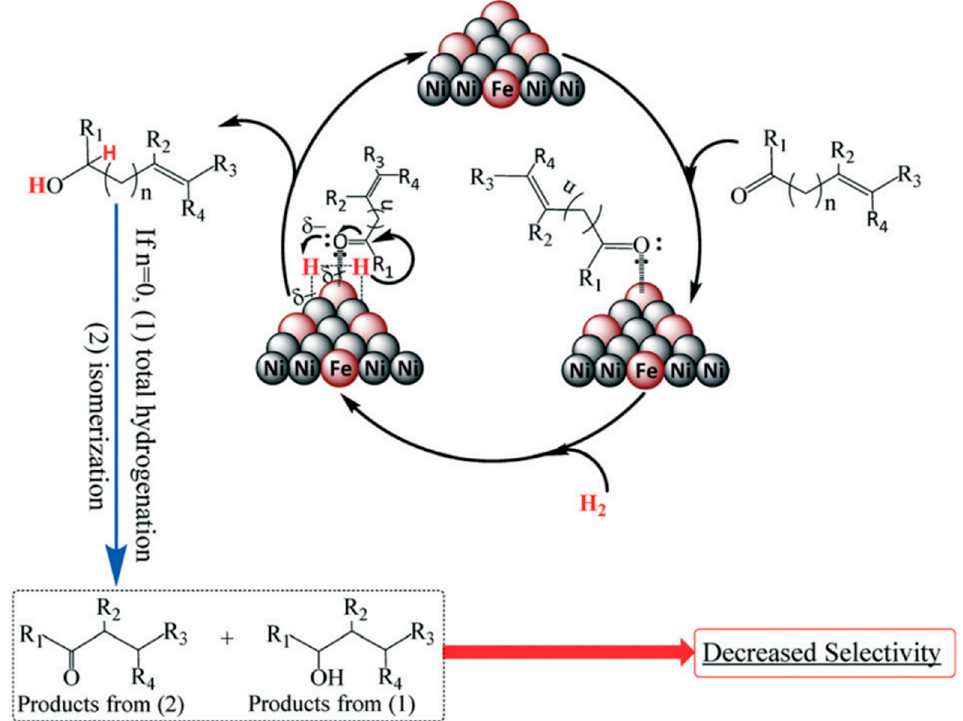
Scheme 2. Plausible mechanism for the chemoselective hydrogenation of unsaturated carbonyl compounds to the corresponding unsaturated alcohols by Ni-Fe-based alloy. Adapted from [65] with permission of Royal Society of Chemistry, copyright 2017.